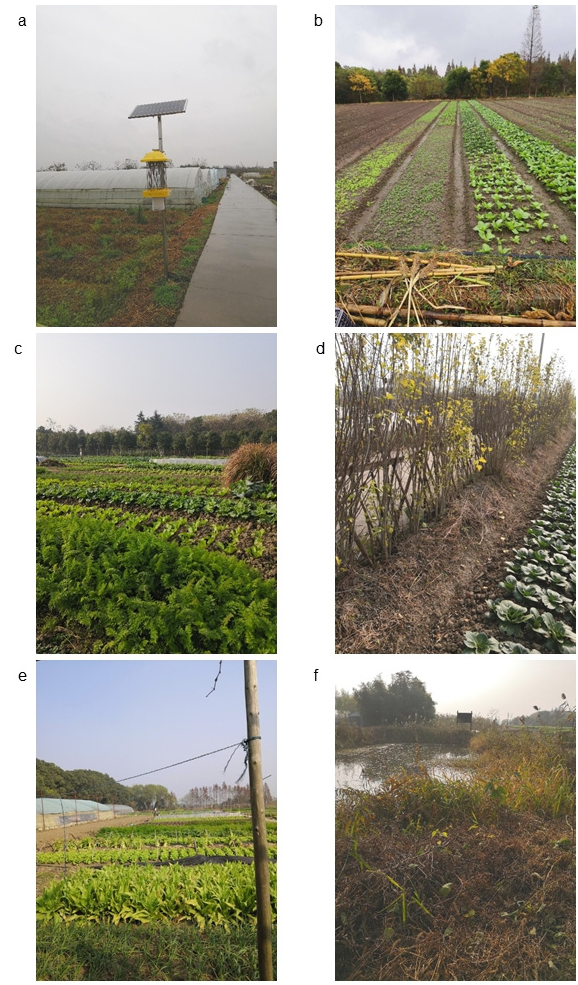
Figure 1. Pictures taken in November–December 2019 in Mengtian on Chongming Island, Miuer and Cen-gu Farms in Qingpu District in Shanghai: ( a ) light appeal equipment for flying pests in Mengtian; ( b ) the field view of Mengtian Farm, and behind the field, the stratified vegetation with bushes and trees; ( c ) the tiny field plots of Miuer Farm; ( d ) the clogs tree fence along the farm road; ( e ) the overview of Cen-gu Farm, where trees are growing along the lake; ( f ) part of the environmental treatment project of Cen-gu, a sedimentation pond.